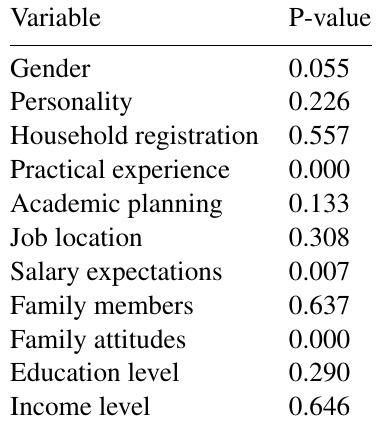
Table 9 Cross-analysis table of multivariate and employment